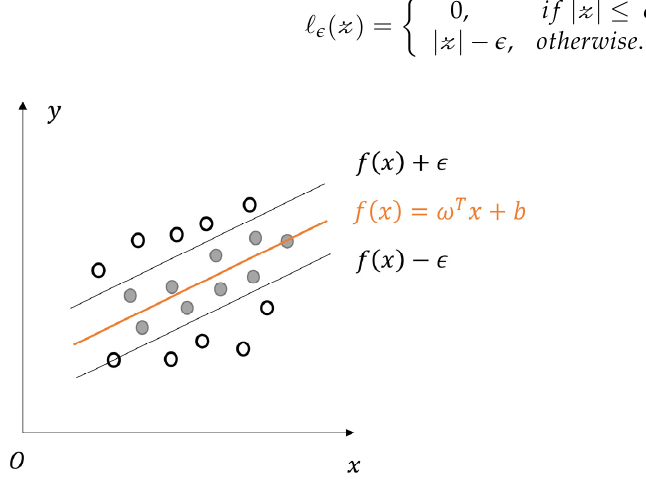
Figure 10. Sketch diagram for SVR.